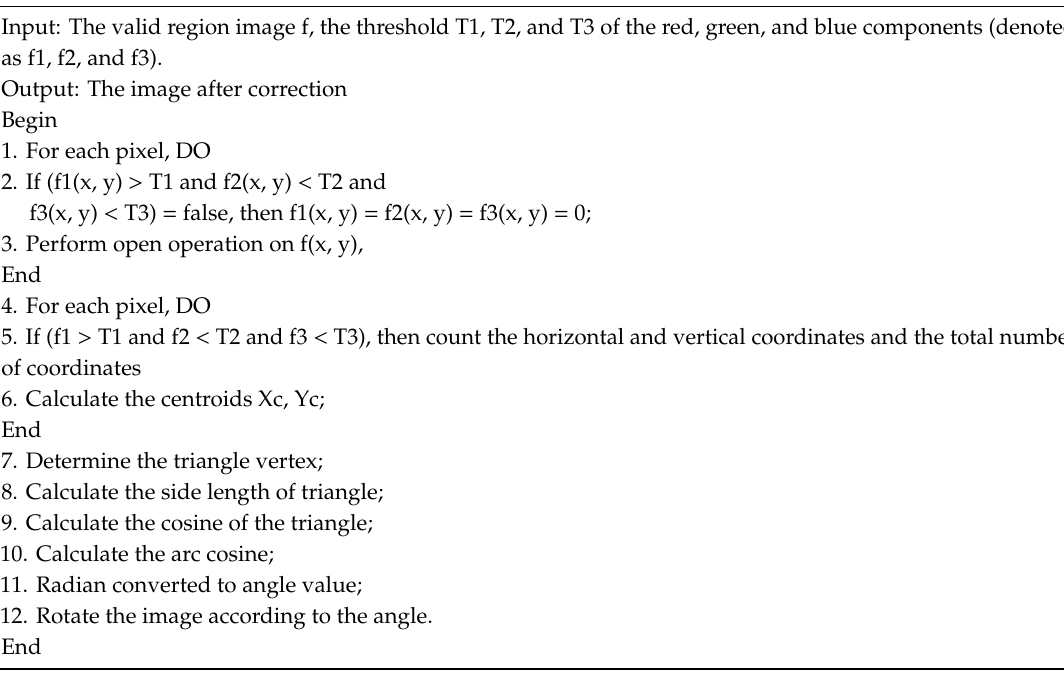
Algorithm 1. Procedure for the Northing Correction